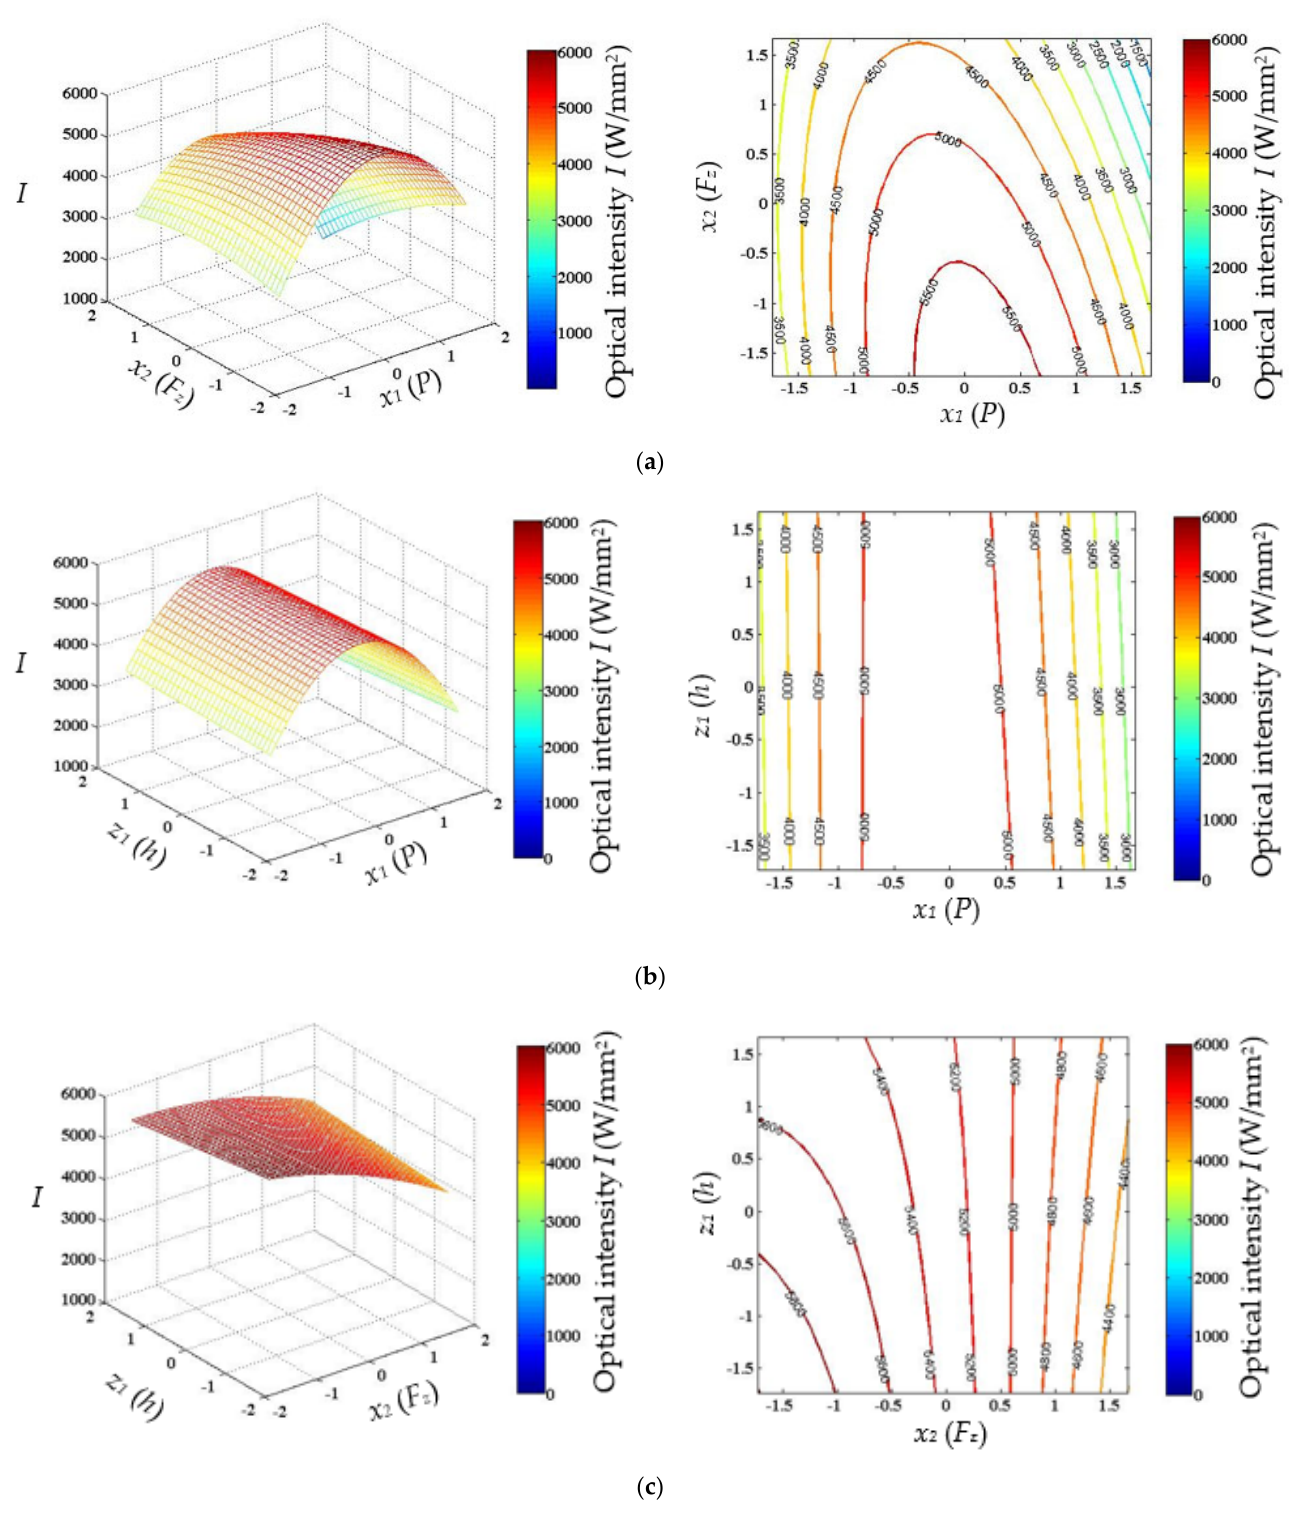
Figure 11. Response surfaces and contours of optical intensity as the function of any two variables among x 1 , x 2 , and z 1